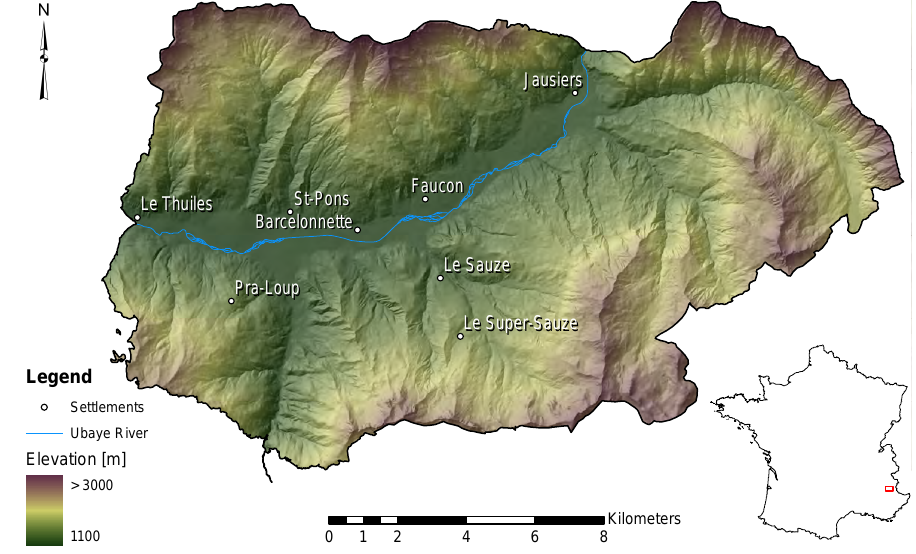
Fig. 1. Hillshade of the Barcelonnette Basin (Southern French Alps) with the location of the most important human settlements and the Ubaye